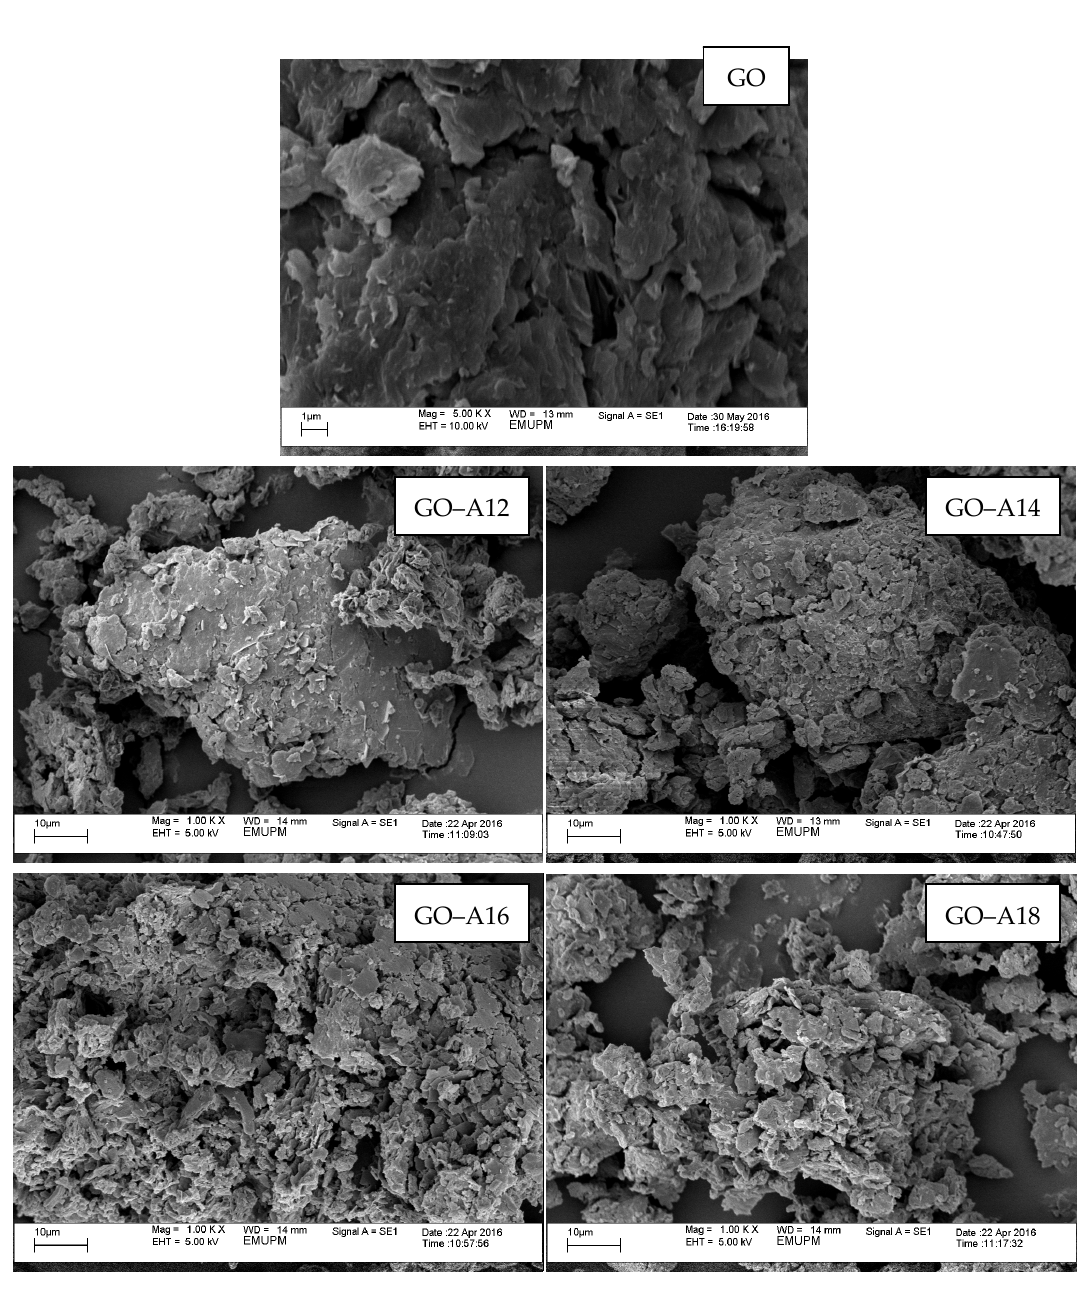
Figure 6. SEM microscopy of GO and functionalized GO.